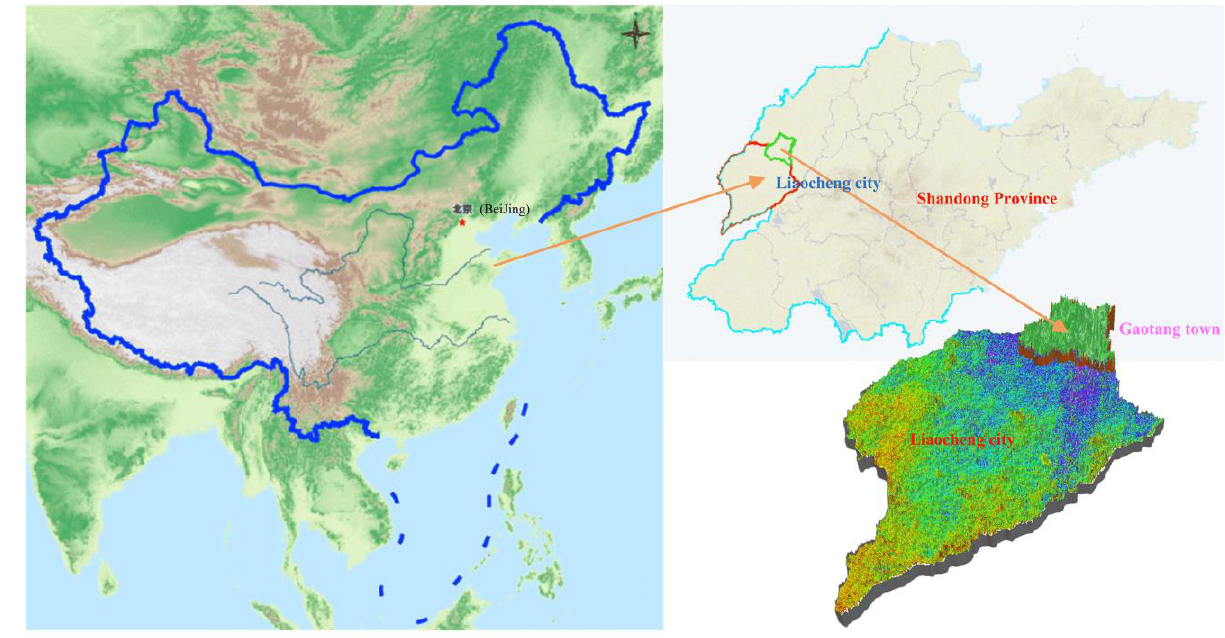
Figure 1. Map of the study area.